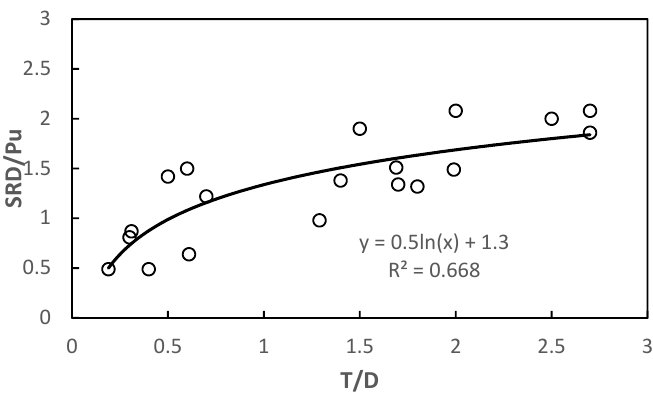
Figure 6. Relationship between SRD/Pu and T/D.